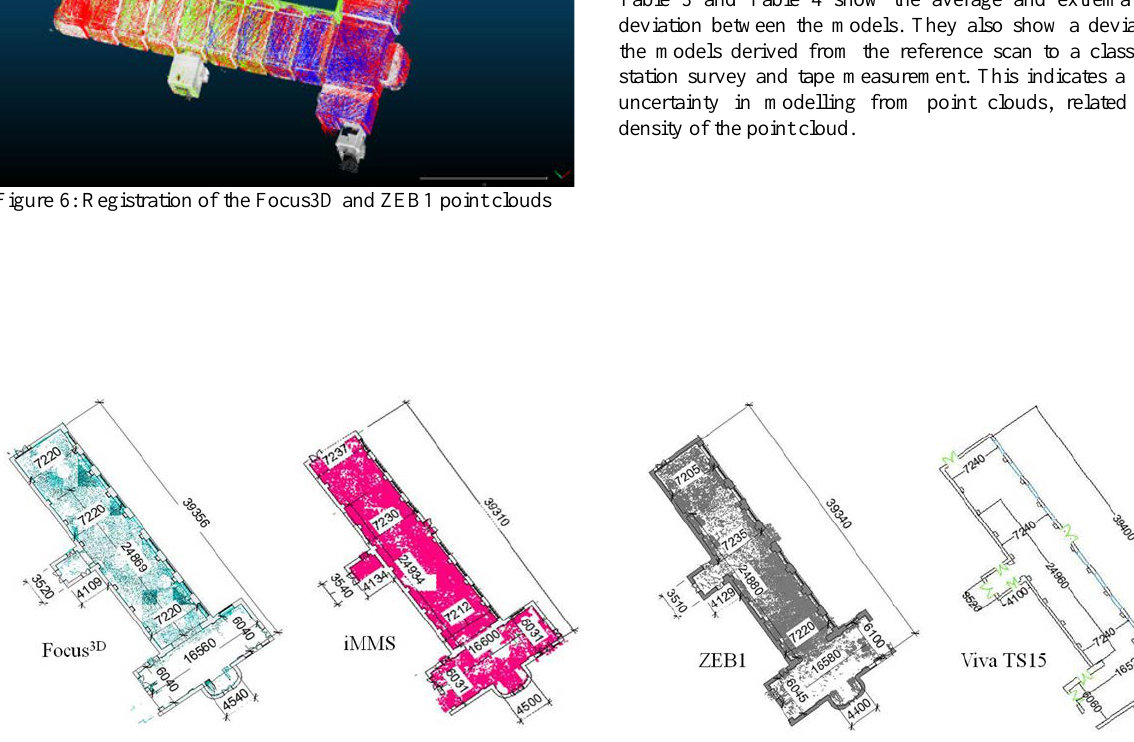
Figure 5: Distance measurements extracted from the BIM. Left to right the models derived from Focus3D, i-MMS, ZEB1 and TS15 are shown. All measurements are in